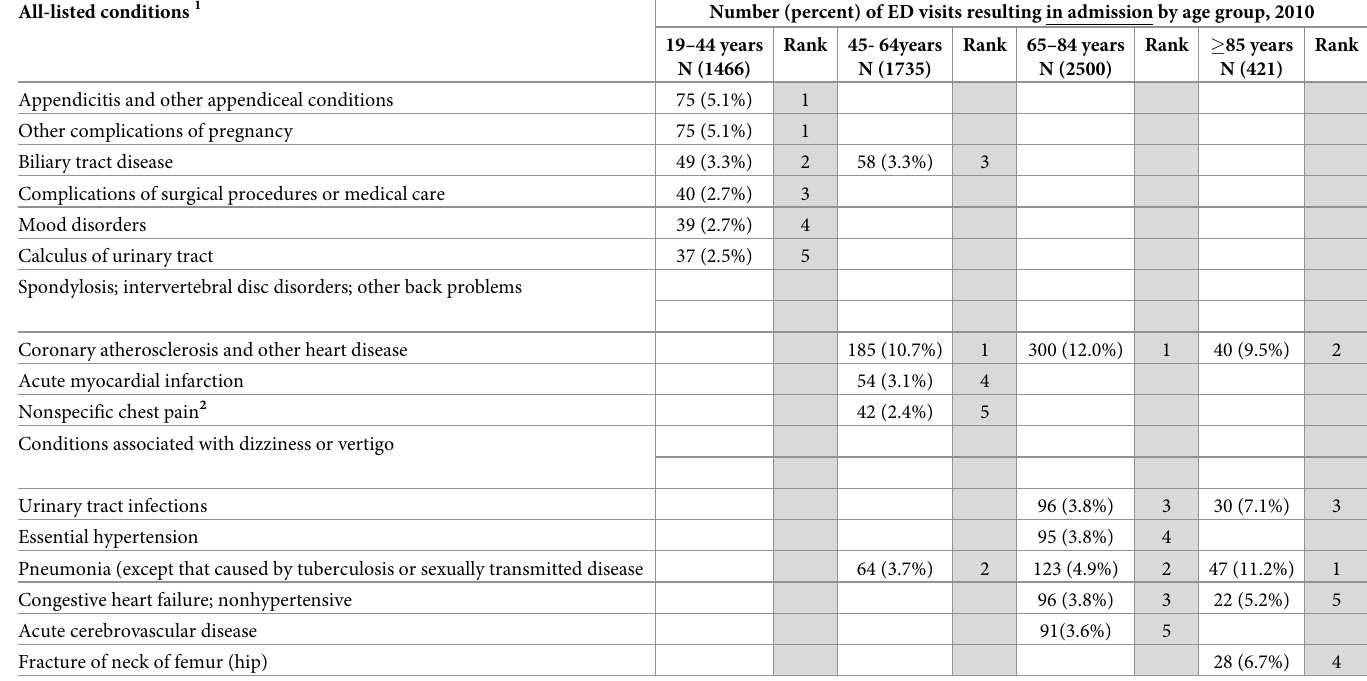
Table 6. Top listed conditions for adult ED visits who were admitted to the hospital by age group, 2010–2011.